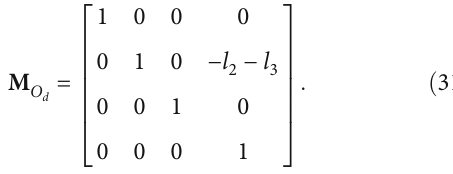
Figure 6: Workspace of the fi ngertip with respect to frame f O index fi